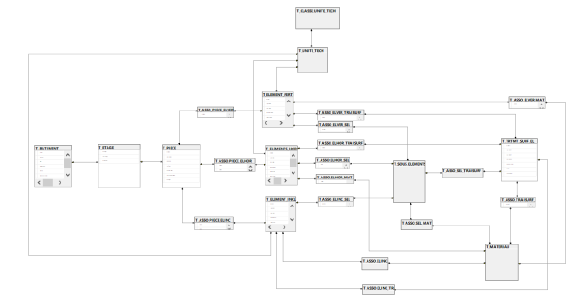
Figure 10 . Actual UML Diagram of the database